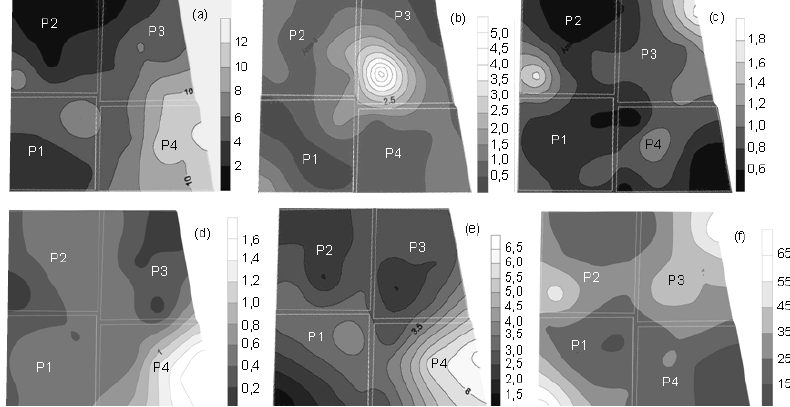
Figura 5. Mapas de contorno de atributos químicos do solo selecionados na profundidade de 40 a 60 cm, das parcelas experimentais da PIF coco, Frutese, Platô de Neópolis, SE, em que P1, P2, P3 e P4 são, respectivamente, as parcelas 1, 2, 3 e 4: (a) CO (g kg -1 ); (b) P (mg kg -1 ); (c) Ca + Mg (cmol (cmol kg -1 ); (e) CTC (cmol kg -1 ); e (f) V c c